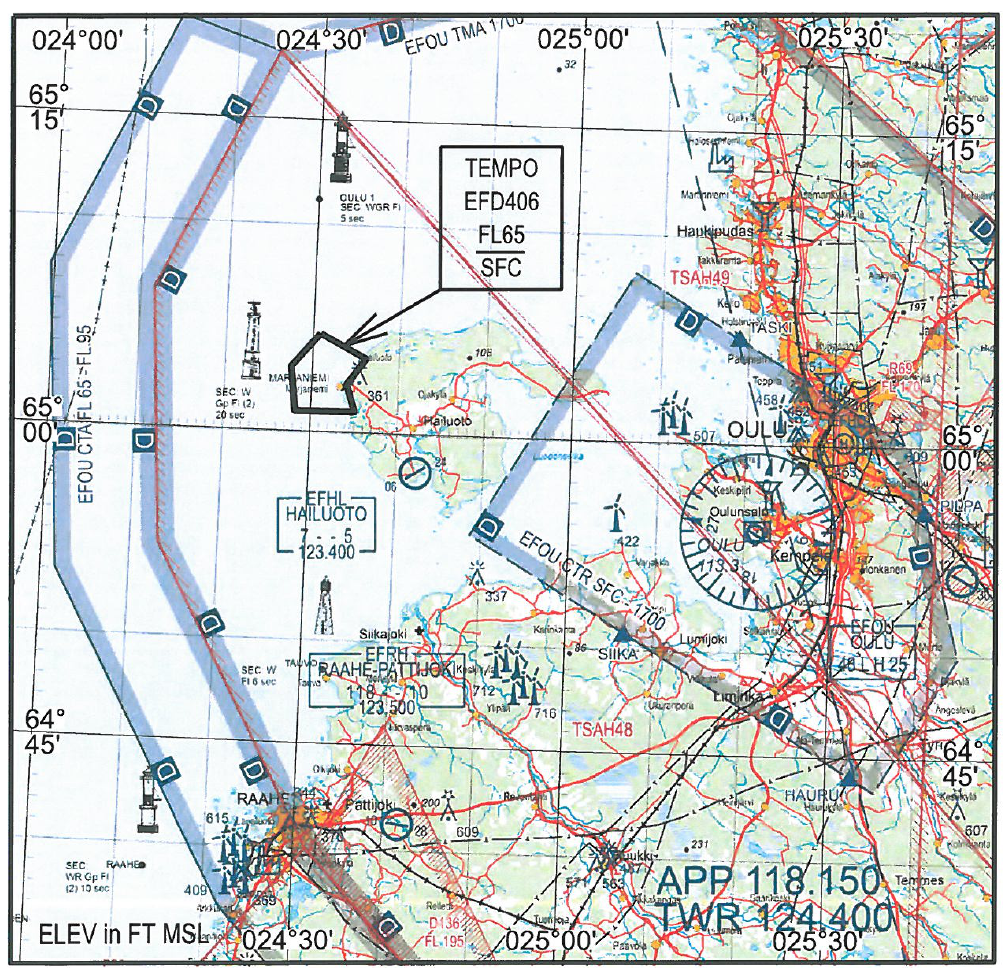
Figure 3. Aviation map of the area around Oulu airport. The danger area reserved for our UAV operations is outlined in bold and labeled as TEMPO EFD406 (Source: ANS Finland Aeronautical Information Services AIP Supplement